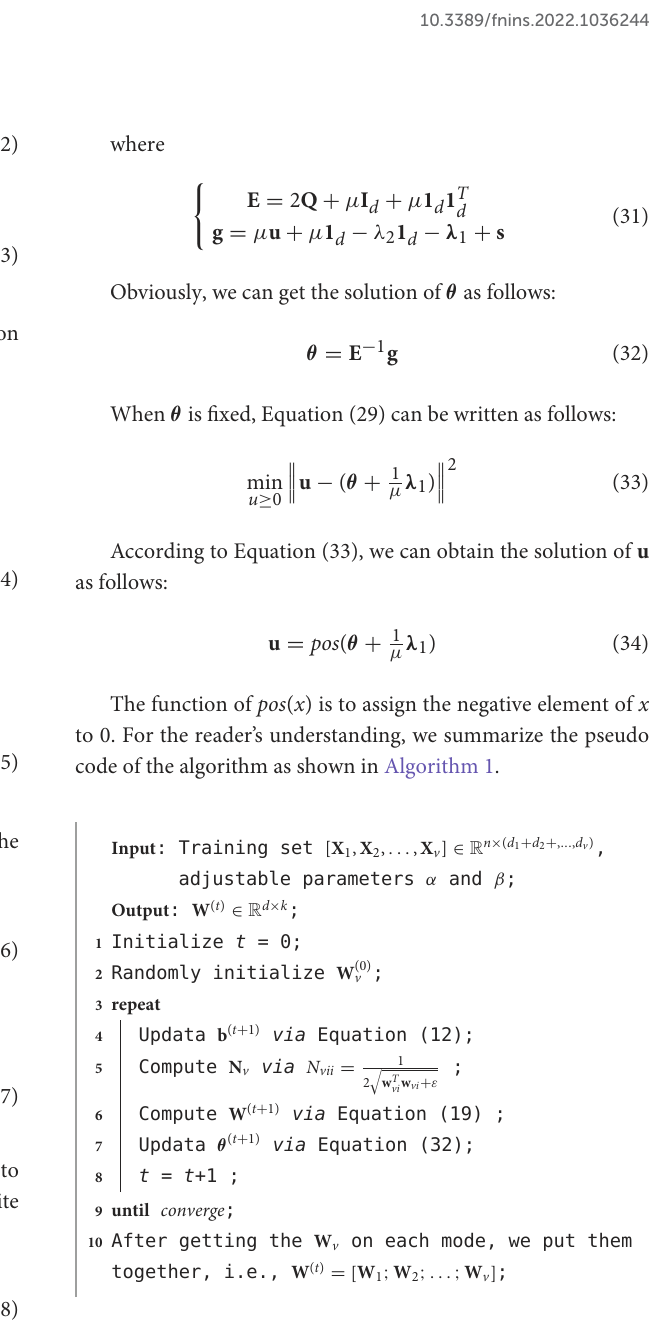
Algorithm 1. Pseudo code for proposed